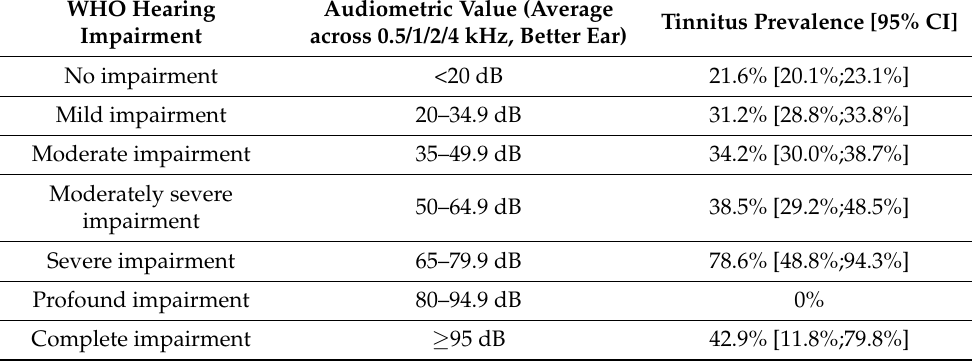
Table 2. Tinnitus prevalence depending on hearing loss according to WHO grading of hearing